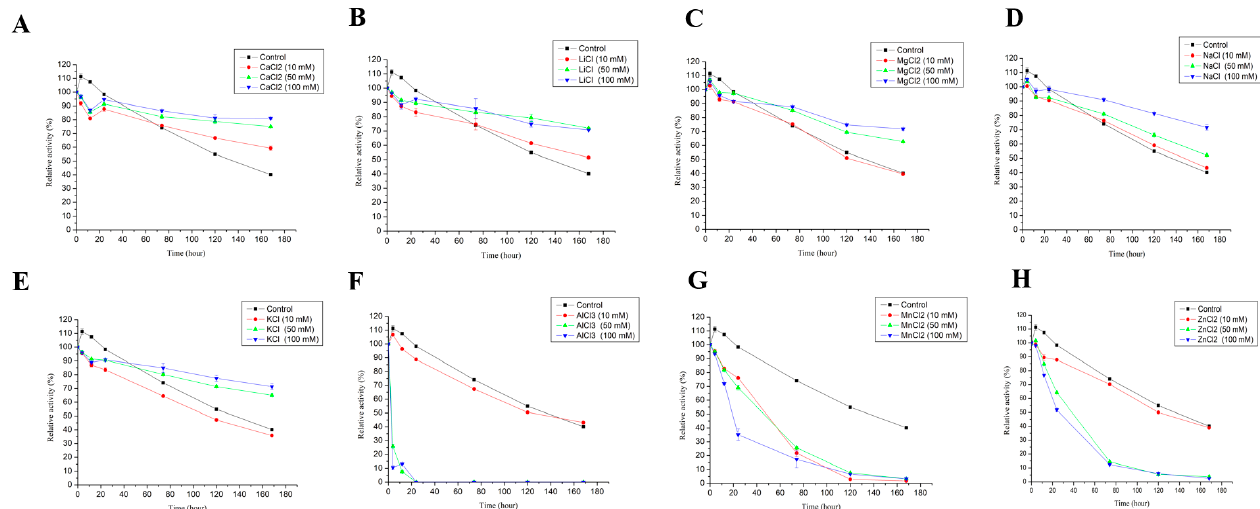
Figure 4. Effects of different metal ions on the stability of LAC-4 laccase. ( A ) CaCl 2 , ( B ) LiCl, ( C ) MgCl 2 , ( D ) NaCl, ( E ) KCl, ( F ) AlCl 3 , ( G ) MnCl 2 , ( H ) ZnCl 2 . Control, no addition of any metal ion.